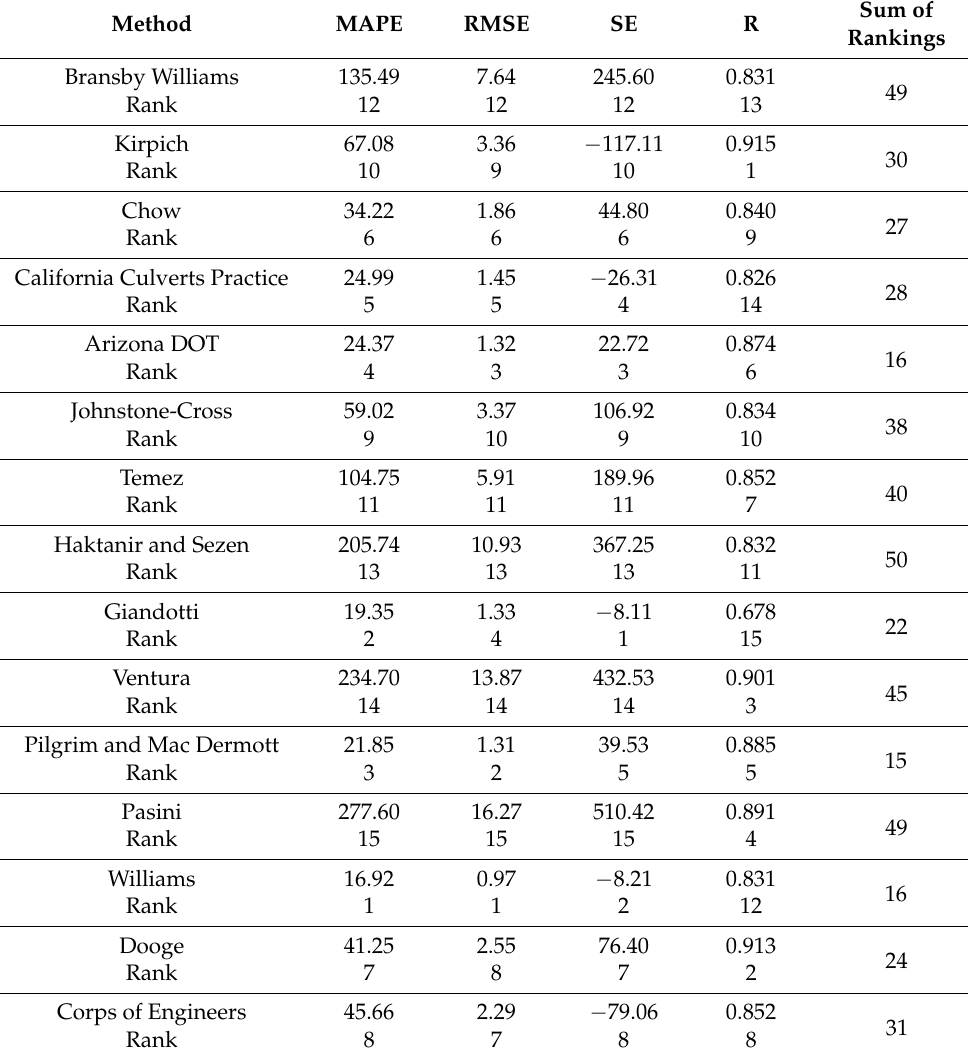
Table 7. Values of statistical measures and the ranking of methods.